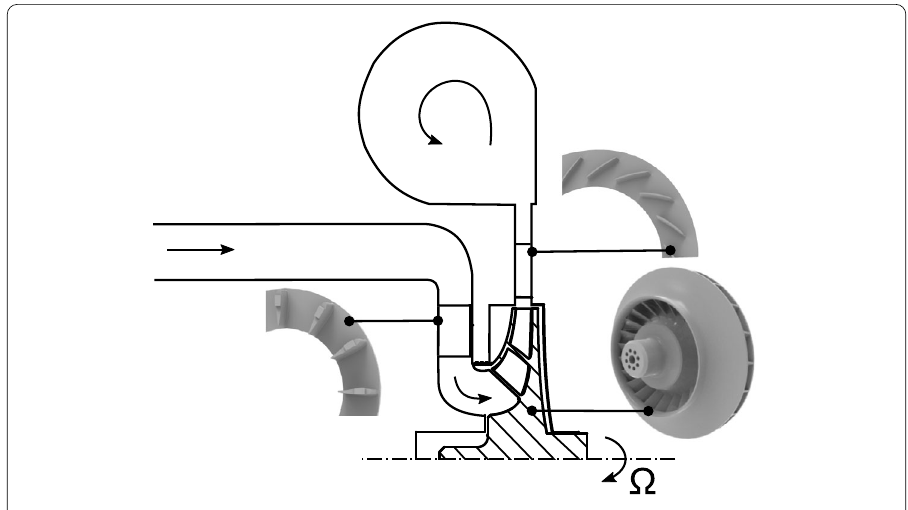
Figure 6 Meridional view of the compressor stage and 3D representation of the IGV, impeller and diffuser